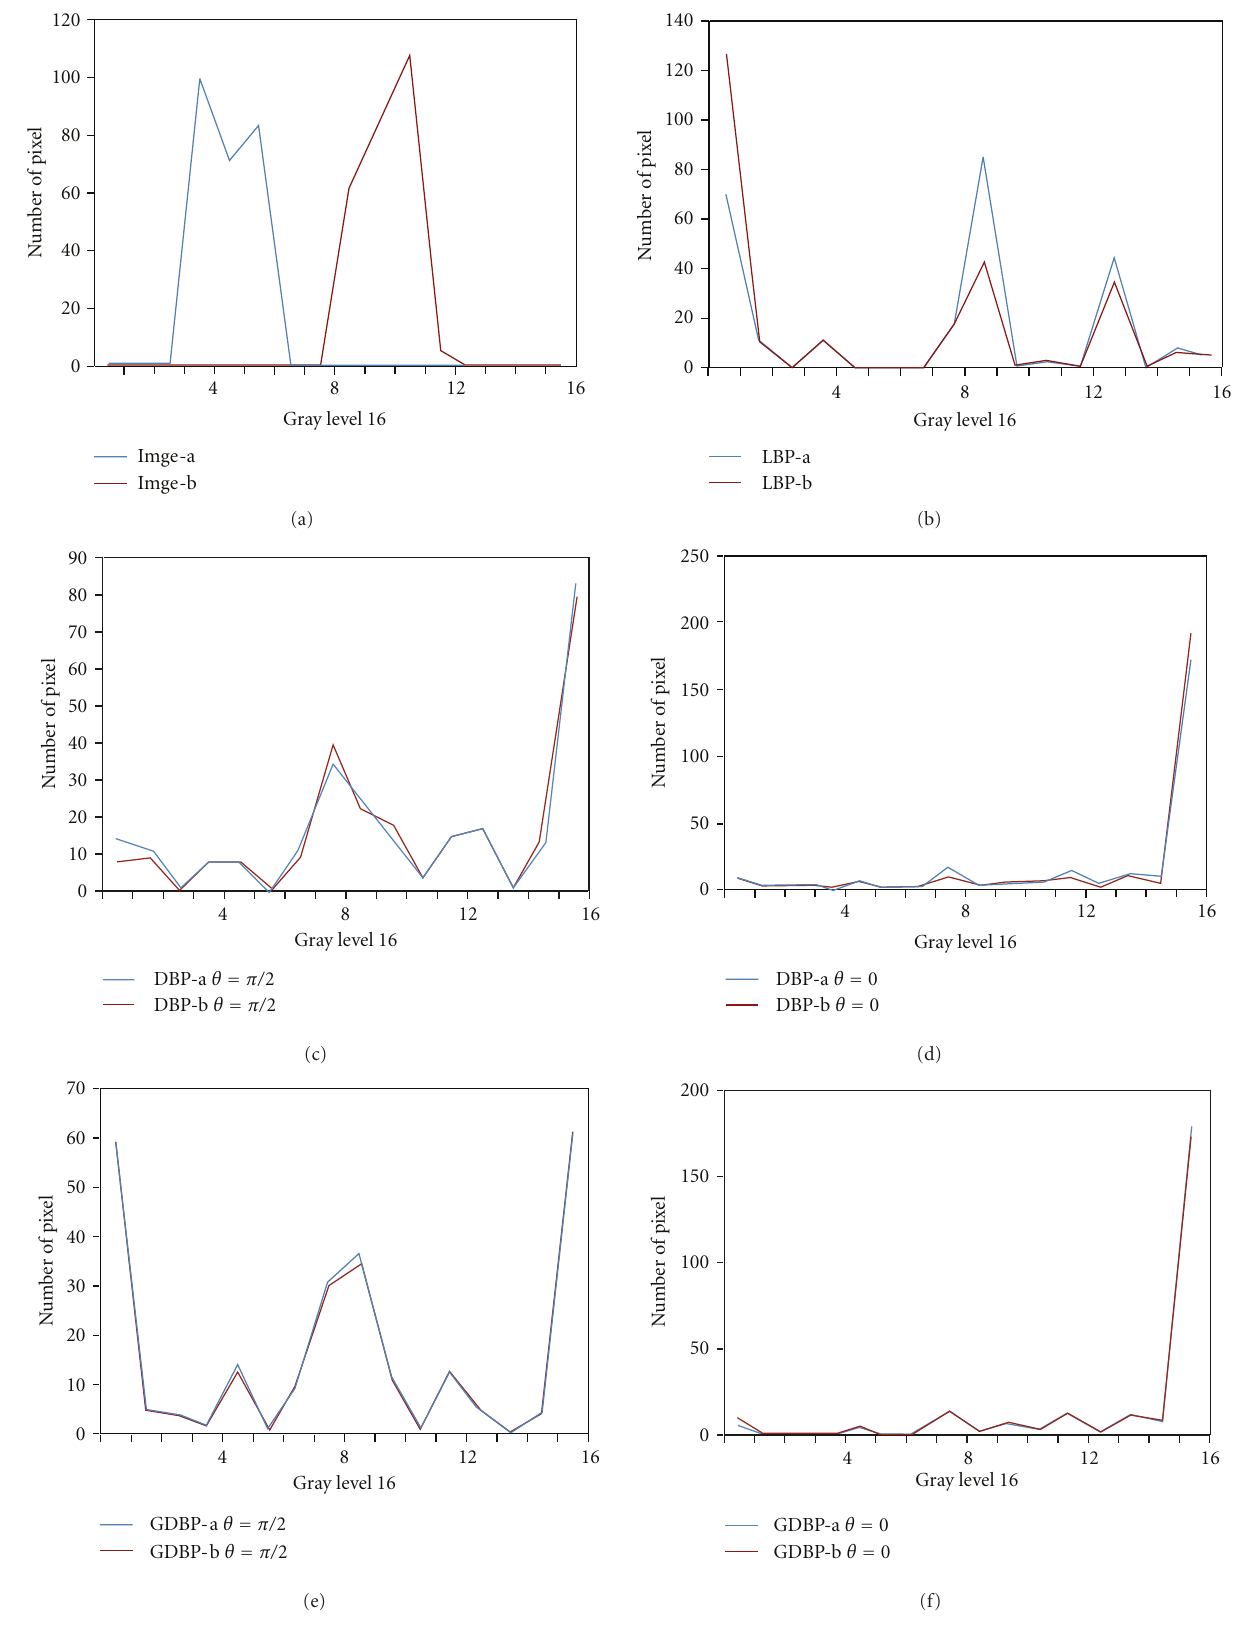
Figure 4: Robustness of the di ff erent histogram to images with lighting variation. GDBP (a, b), LBP (a, b), and DBP (a, b) mean that three operators are, respectively, applied on the white regions of image a and image b (see Figure 3), and θ is the direction of GDBP and